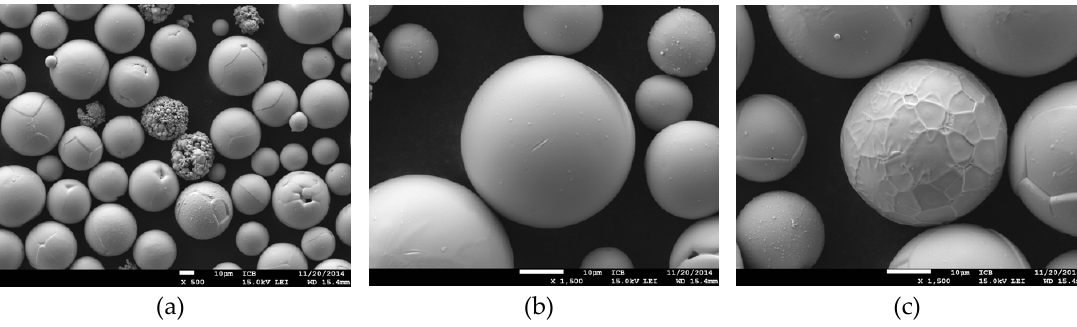
Figure 1. ( a ) SEM image of molybdenum powder Mo-45 (Tekna); ( b ) and ( c ) SEM images with a higher magnification showing different powder morphologies.